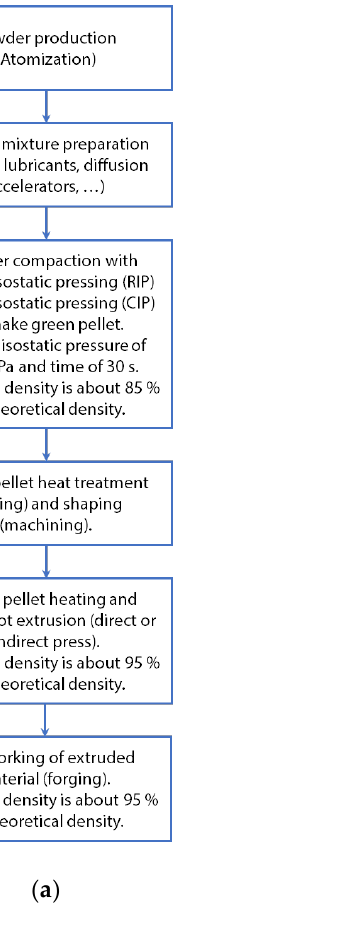
Figure 12. Technology and process routes for ( a ) Al 1080 powder and ( b ) conventional AA 1050 alloy.